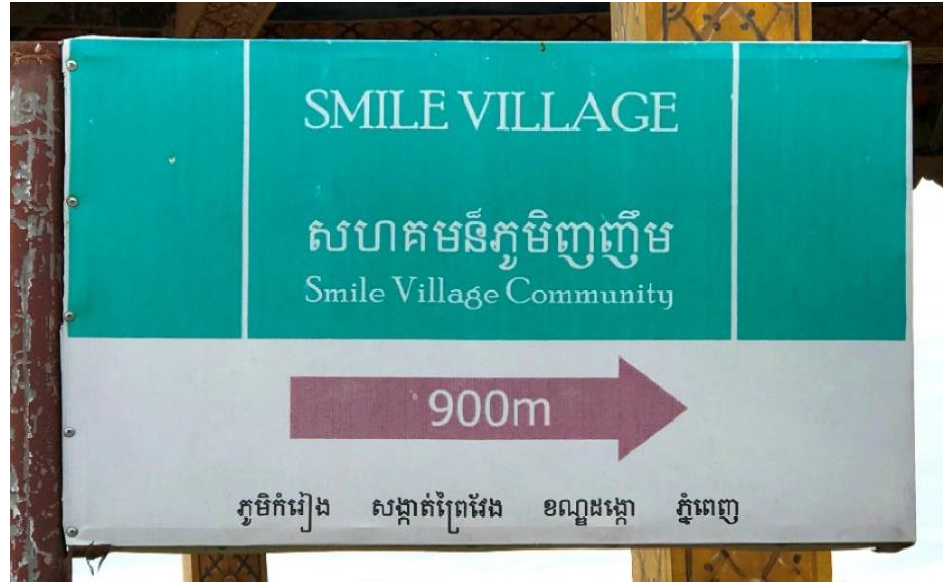
Figure 1. A main street’s direction label to Smile Village community. Source: Author.